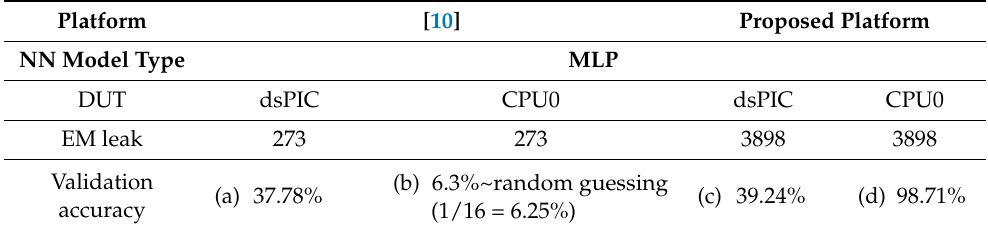
Table 8. Top1 accuracy comparisons between [10] and the proposed platform.